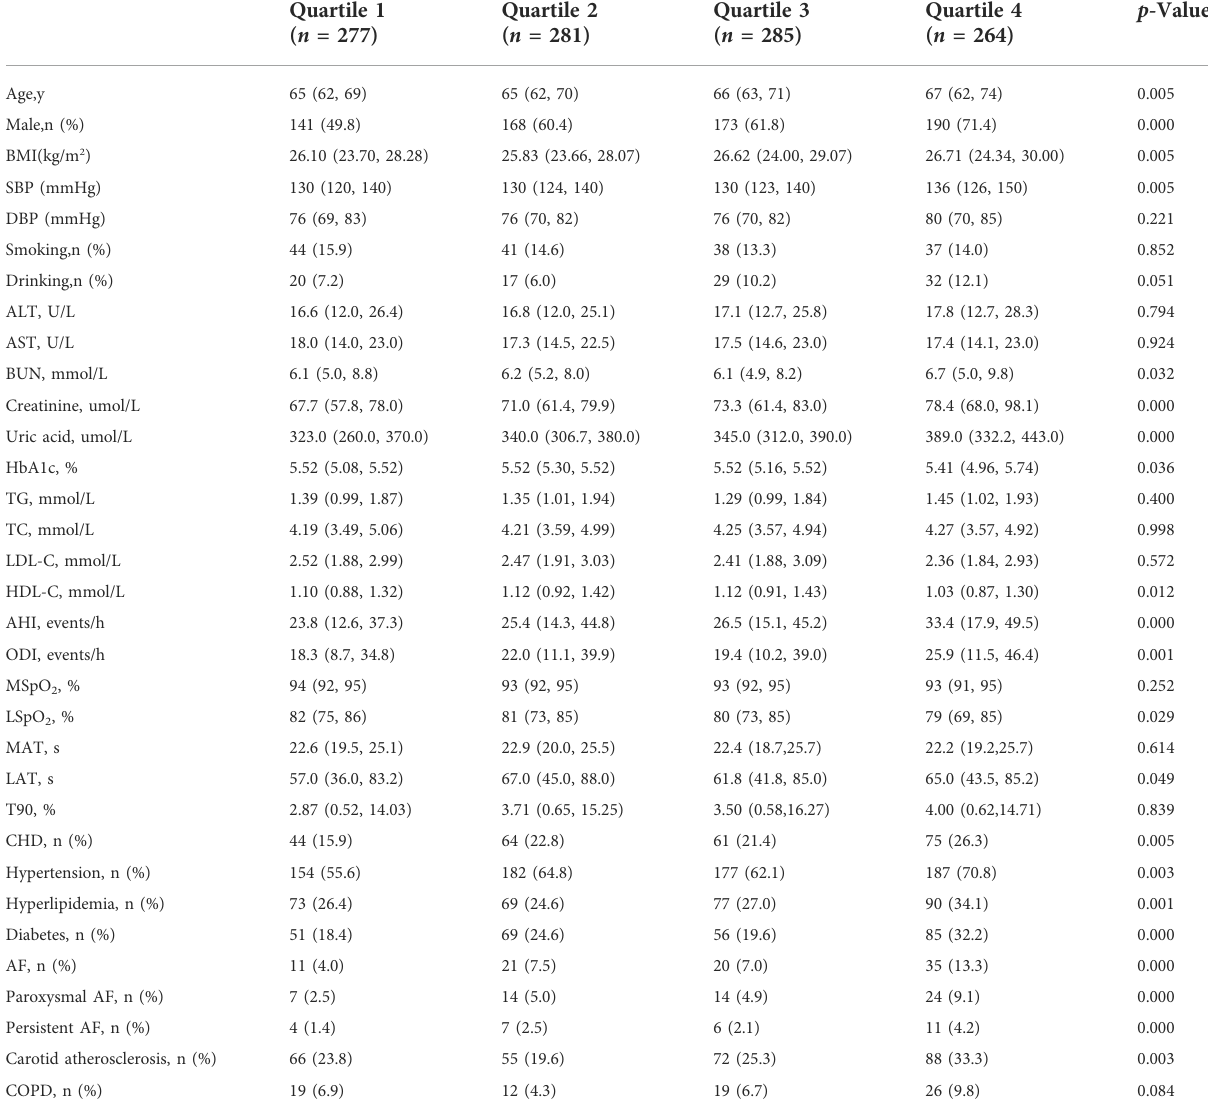
TABLE 1 Characteristics of elderly OSA participants according to quartiles of serum Cys-C. Quartile 1 ( n =